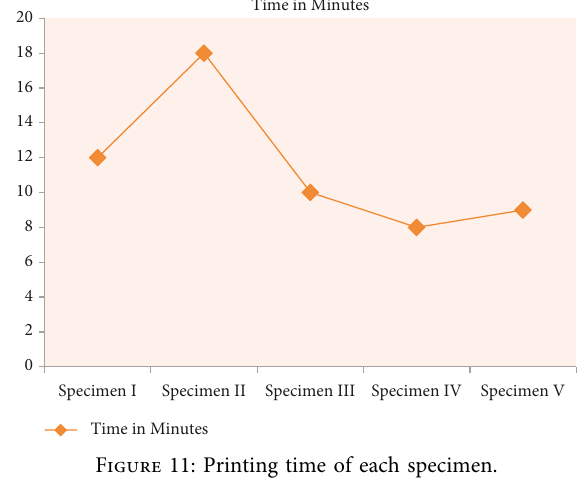
Figure 11: Printing time of each specimen.